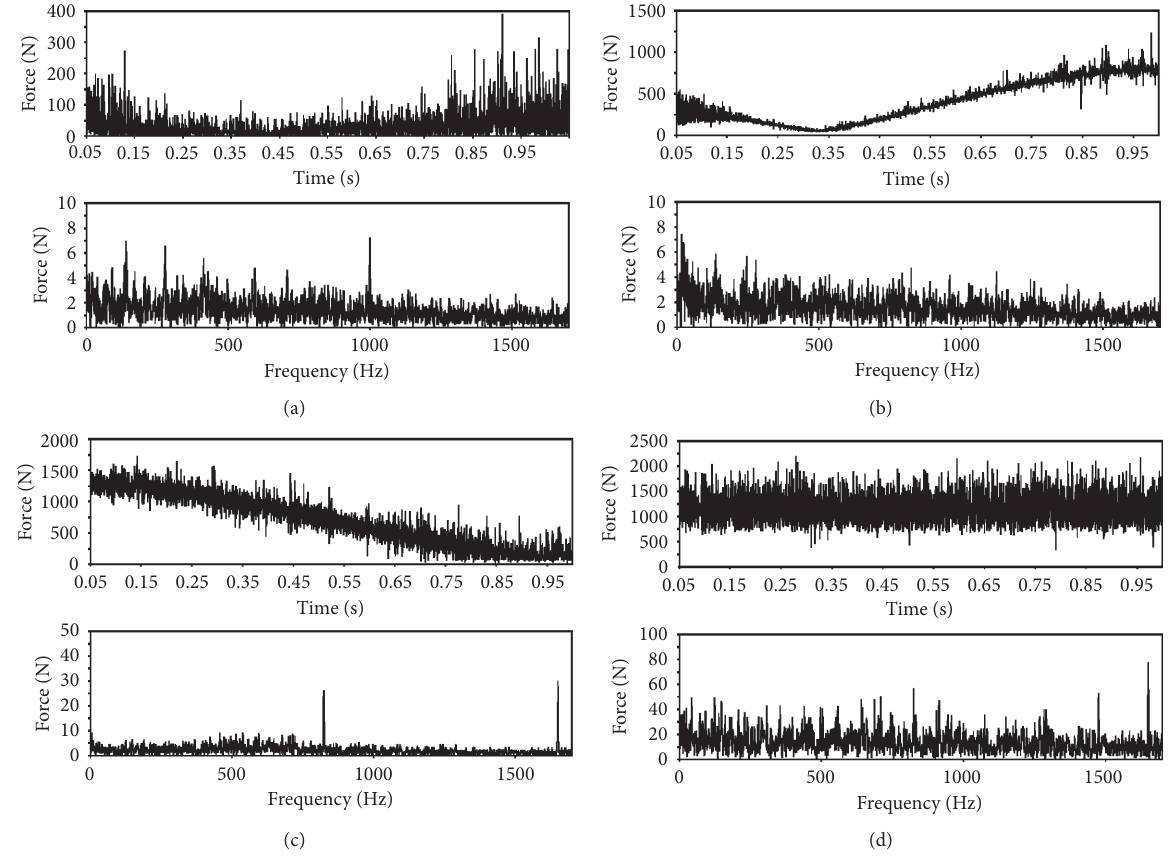
Figure 16: The time-domain and frequency-domain characteristics of the bearing restraint force. (a) Input shaft bearing of engine. (b) Input shaft bearing of MG1. (c) Input shaft bearing of MG2. (d) Bearing of composite ring